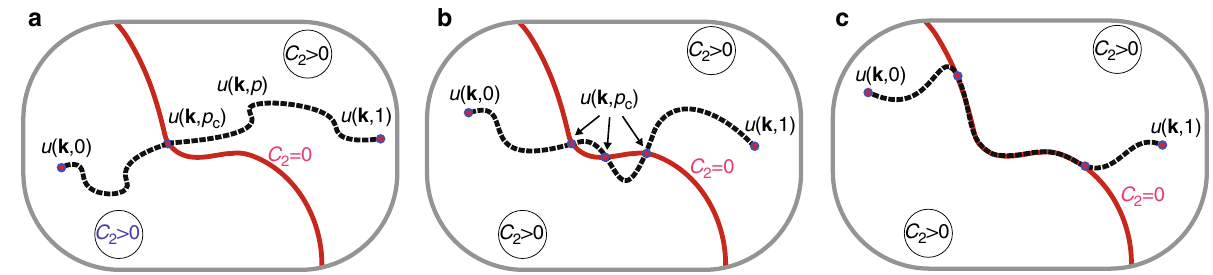
Fig. 2 Evolution trajectories of the degree distribution during edge removal. An example of a scenario when the network: a becomes critical once along the trajectory, b becomes critical at three disjoint points, and c becomes critical on a continuous interval of